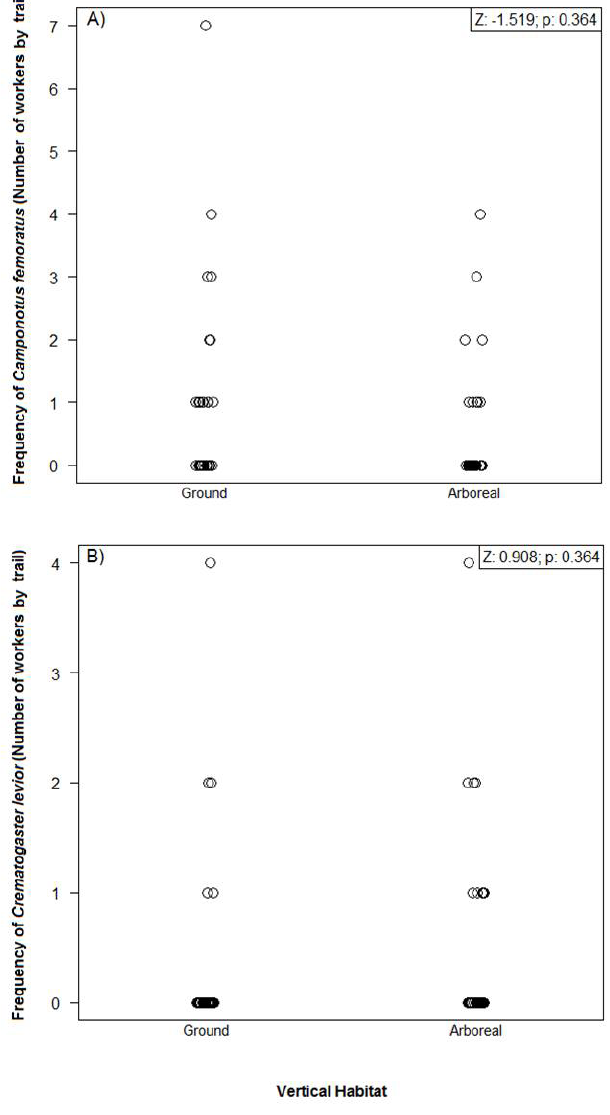
Fig 1 . Works frequency by trail in vertical stratum (ground and vegetation). A) Camponotus femoratus (B Crematogaster levior.